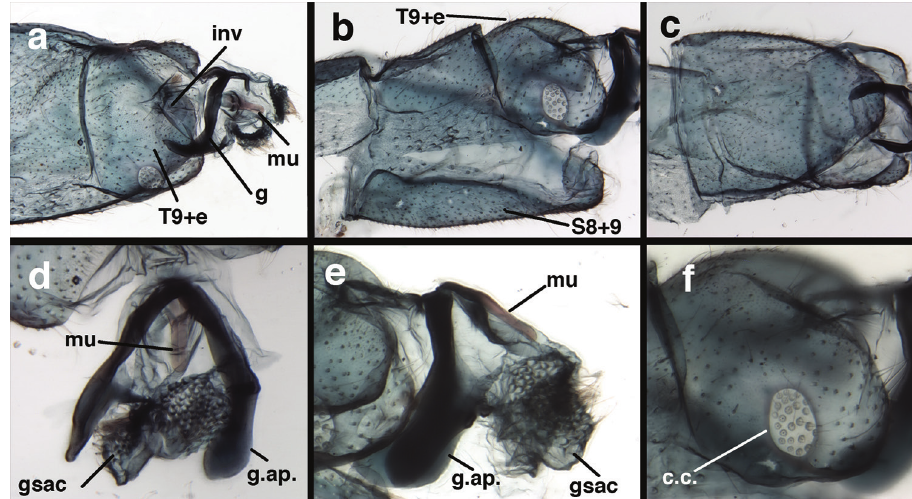
Figure 82. Chrysopa siderocephala Navás: Male terminalia, ( a ) terminalia, dorsal ( b ) terminalia, lat- eral ( c ) fused sternites 8+9, ventral ( d ) gonarcus, frontal ( e ) gonarcus, lateral ( f ) tergite 9 + ectoproct, lateral. c.c. callus cerci g gonarcus gsac gonosaccus g.ap. gonarcal apodeme inv dorsal invagination of T9+ectoproct mu mediuncus S8+9 fused eighth and ninth sternites T9+e fused ninth tergite and ectoproct (Peru, Lima, lectotype,